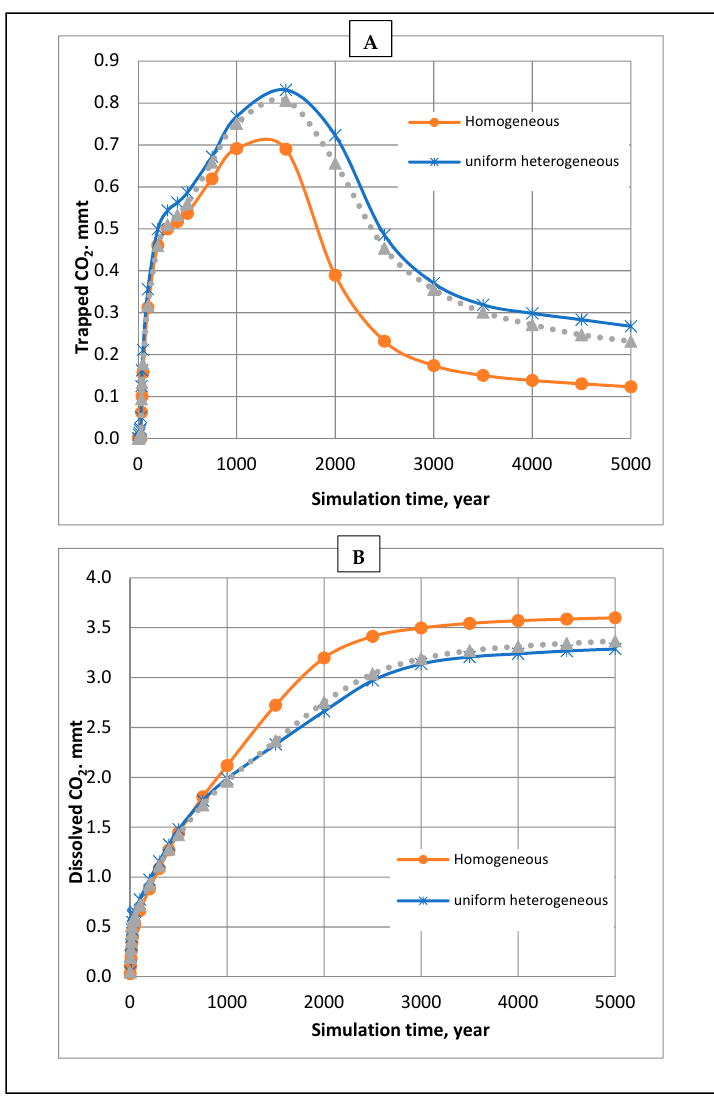
Figure 5. Effect of heterogeneity for cases 1, 2 and 3 on ( A ) CO 2 residual trapping and ( B ) dissolved CO 2 .